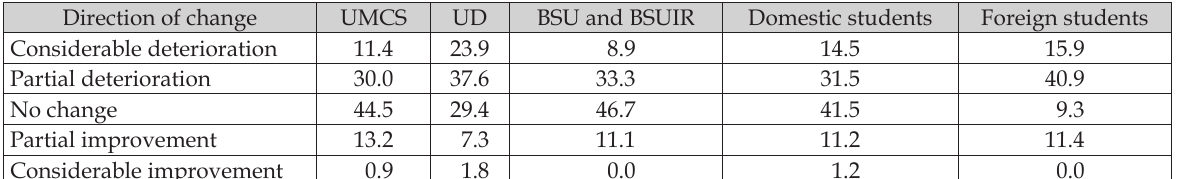
Table 2. Respondents’ material situation in Lublin, Kyiv and Minsk, % (n = 380).